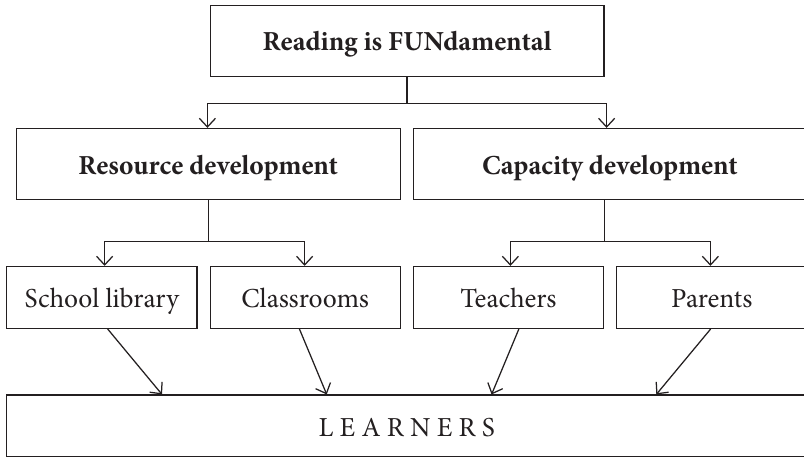
Figure 1: Model of multi-level reading intervention programme